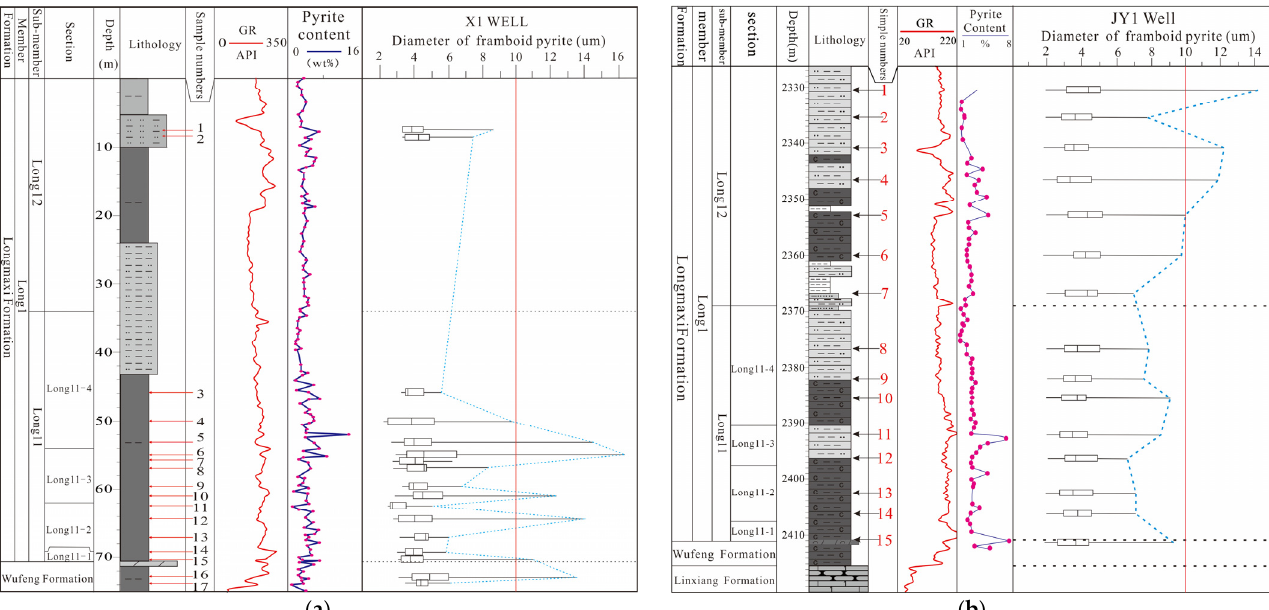
Figure 5. ( a ) Logs of the Wufeng–Longmaxi Formation from the X well pyrite framboids represented as “box-and-whisker” plots, where the “box” depicts the 25th and 75th percentiles of framboid distributions, the “whiskers” depict the minimum and maximum framboid diameters, and the central line is the median average. ( b ) Logs of the Wufeng–Longmaxi Formation from the JY1 well pyrite framboids represented as “box-and-whisker” plots, where the “box” depicts the 25th and 75th percentiles of framboid distributions, the “whiskers” depict the minimum and maximum framboid diameters, and the central line is the median average.